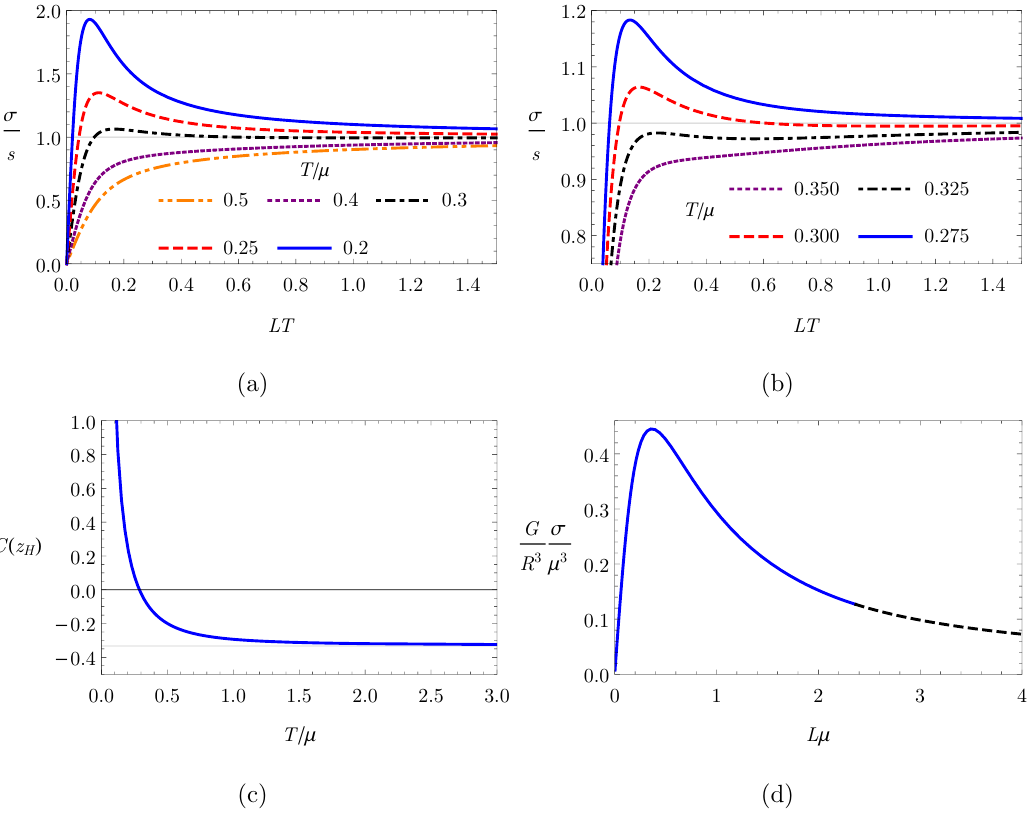
Figure 14. Plots of our results using the solution given by eq. (6.10) ( d = 4, (cid:16) = 1 , (cid:18) = (cid:0) 3 (cid:16) ). (a) The ED, (cid:27) , in units of entropy density s , for the strip, for T=(cid:22) = 0 : 5 down to 0 : 2. (b) Close-up of (a), showing the formation of a local maximum and minimum before the formation of the global maximum as T=(cid:22) decreases from 0 : 350 down to 0 : 275. (c) The dimensionless coe(cid:14)cient C ( z H ) from eq. (2.23) versus T=(cid:22) . As T=(cid:22) ! 1 , C ( z H ) approaches the value for AdS-SCH with d = 4 (the horizontal line). As T=(cid:22) decreases, C ( z H ) changes sign from negative to positive at the ( T=(cid:22) ) 3 from table 4, indicating area theorem violation when T=(cid:22) < ( T=(cid:22) ) 3 . (d) The ED, (cid:27) , in units of (cid:22) 2 R 2 =G , versus L(cid:22) , at T=(cid:22) = 0. The global maximum and area theorem violation remain, although a \phase transition" occurs at L(cid:22) (cid:25) 2 : 37 between extremal surfaces in the bulk (from the blue solid to the black